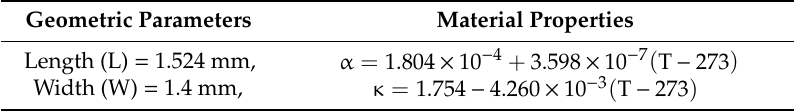
Table 5. Geometric Dimensions and Material Properties (temperature-dependent).